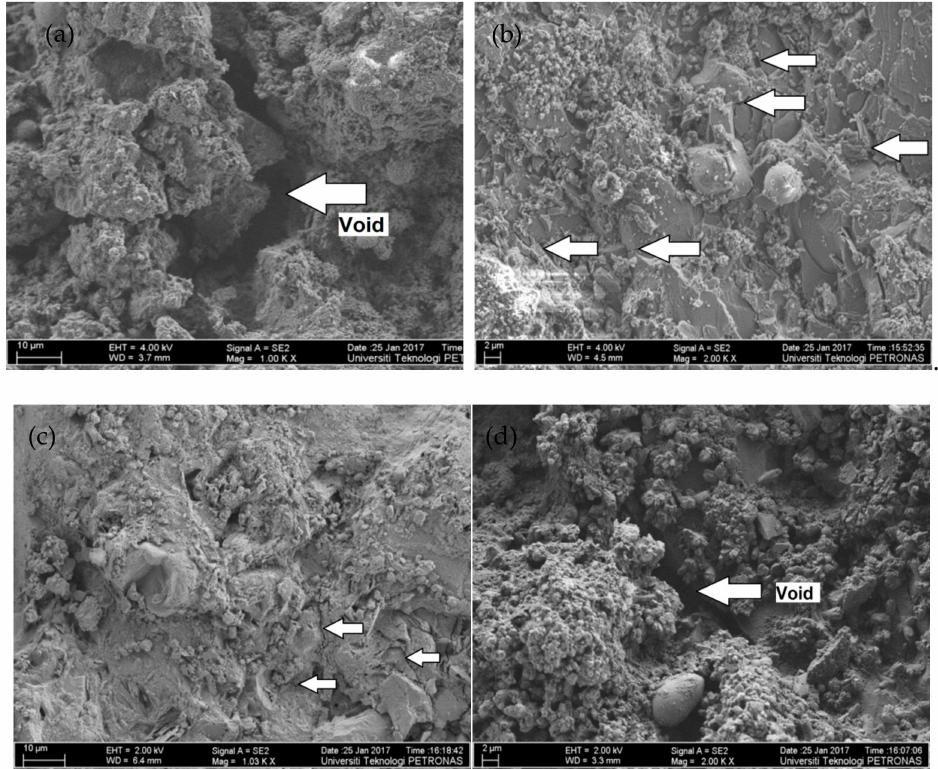
Figure 6. Micrographs of di ff erent concrete mix design ( a ) CM (100% Cement (Arrow pointing void), ( b ) C-MK-10% (Arrows pointing narrow gap), ( c ) C-MK-10%-NS-1% (Arrows pointing narrow gaps), ( d ) C-MK 10% and NS 2% (Arrow pointing